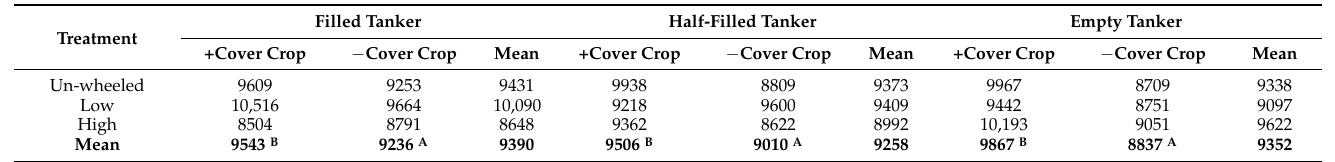
1 12% moisture content; Statistically significant differences ( p < 0.05) are shown for the cover crop effect with capital